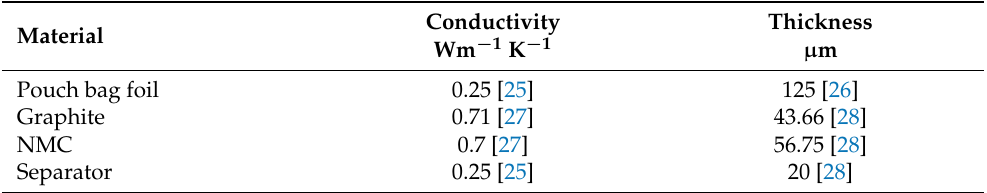
Table 1. Thermal conductivities and layer thicknesses within the LiB.